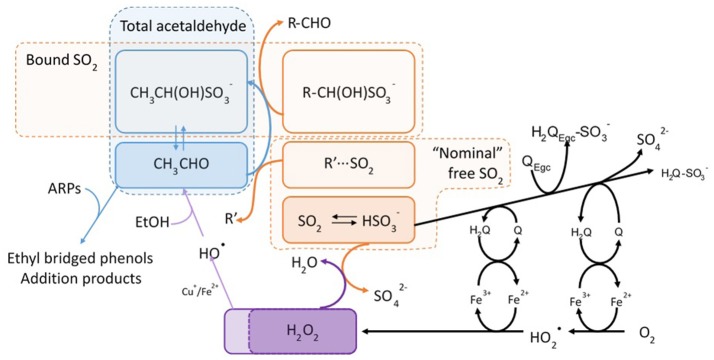
Scheme showing the main elements determining the outcome of wine oxidation when free SO2 levels are low.